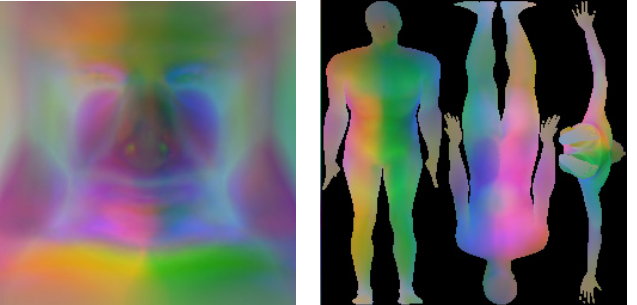
Figure 2. Geometric images. Examples of 128 × 128 geometric images for the facial template ( left ) and 256 × 256 for the body template ( right ). The left body image shows a frontal view, the middle shows a rear view, and the right is viewed from the bottom.